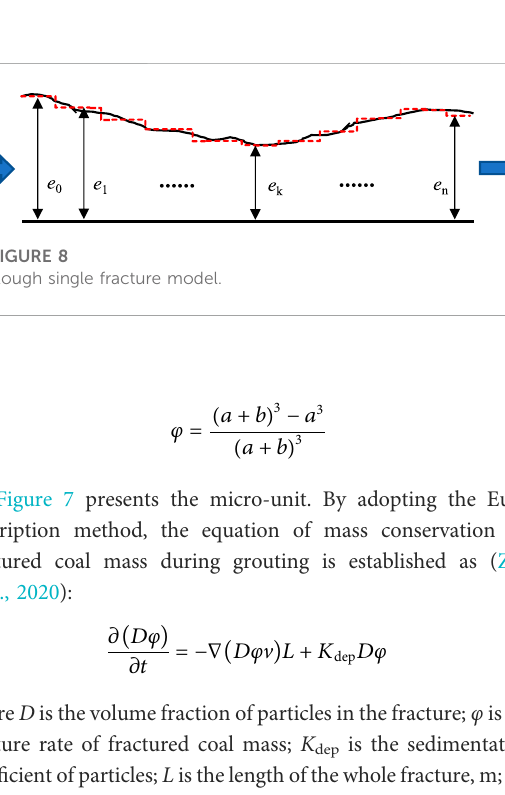
FIGURE 7 Microelement sketch.